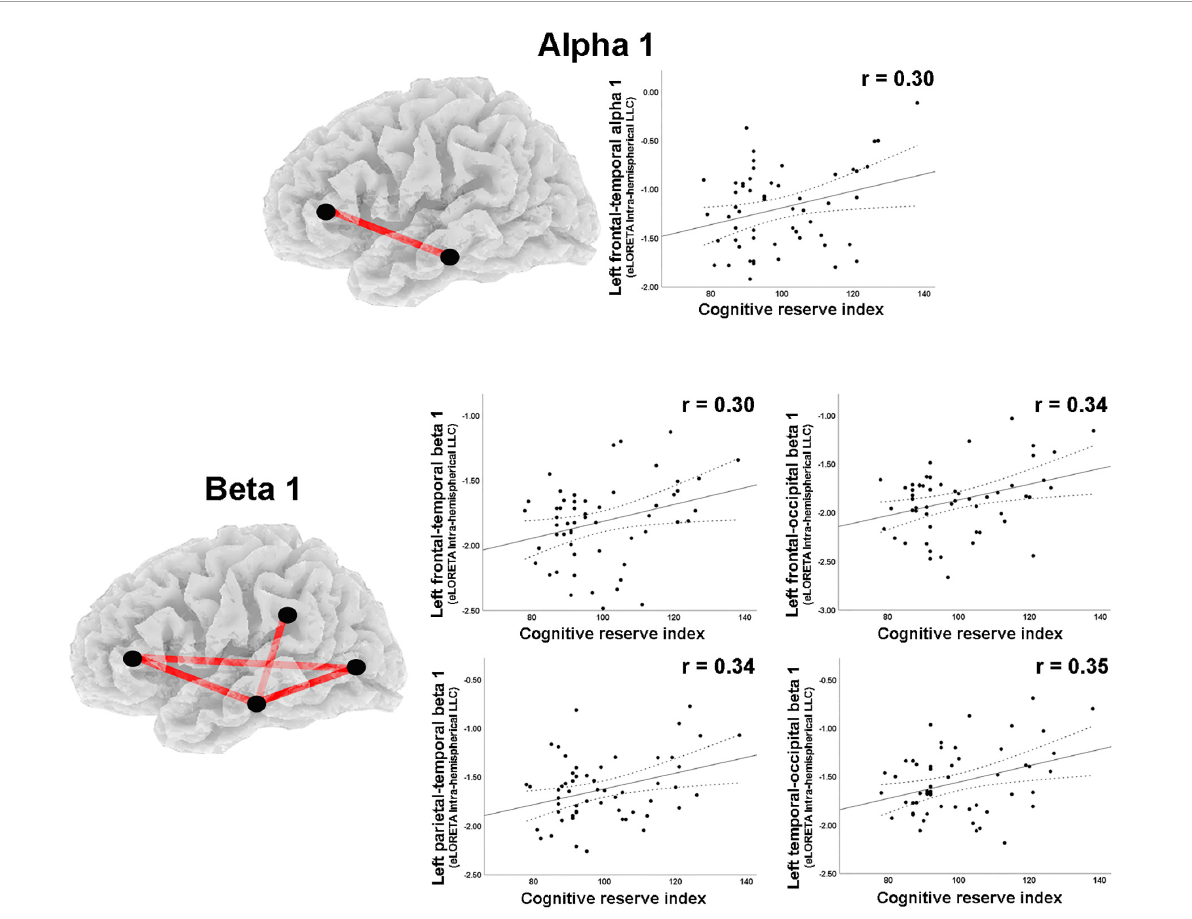
FIGURE6 Graphs and scatterplots with Pearson’s r representing the connections (LLC measures) showing moderate size correlations between left intrahemispheric LLC estimates and the Cognitive Reserve Index ( r ≥ 0.30). The significant correlations were positive for alpha 1 and beta 1 (red